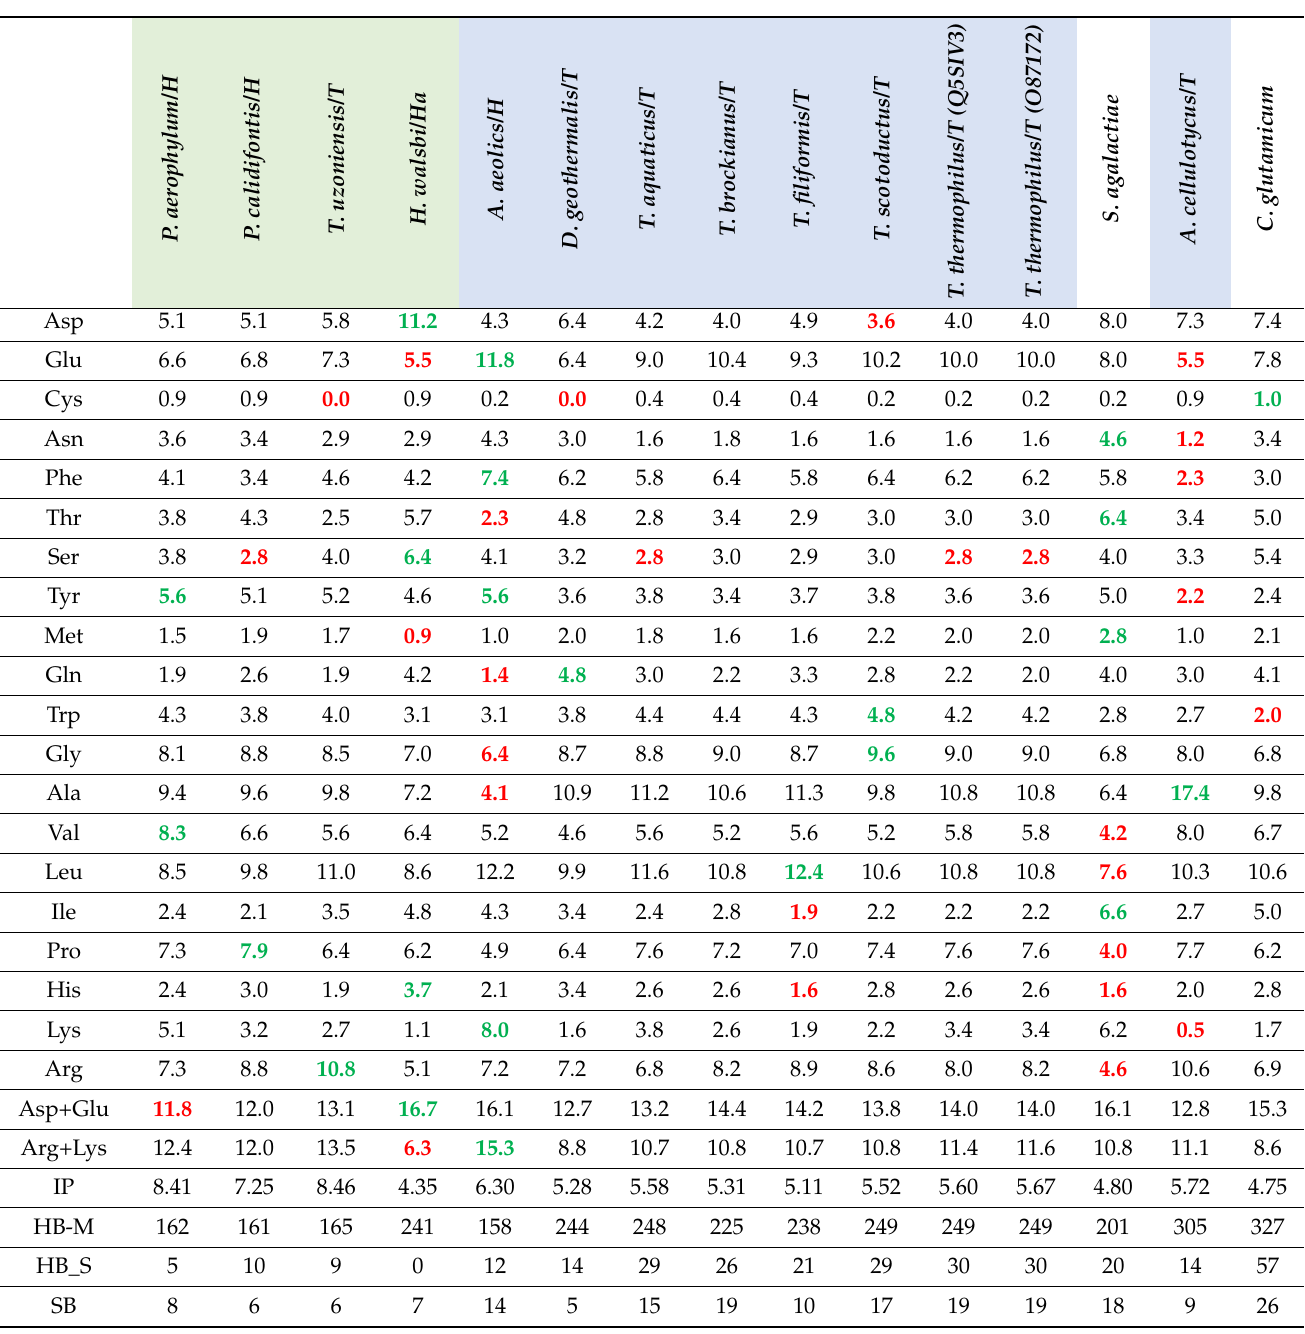
Table 2. Percentages of amino acidic composition, IP, HBs and SBs for amylomaltases from extremophiles. Only the names of species are given, using the same background colours of Table 1. Accession numbers are reported in Table 1. The last two species correspond to amylomaltases with a N -terminal extrasequence. Amino acids are reported according to increasing IP values. The sum of percentages for acidic amino acids (Asp+Glu) and basic amino acids (Arg+Lys) is also given. For each amino acid, the highest (green) and lowest (red) values are reported in